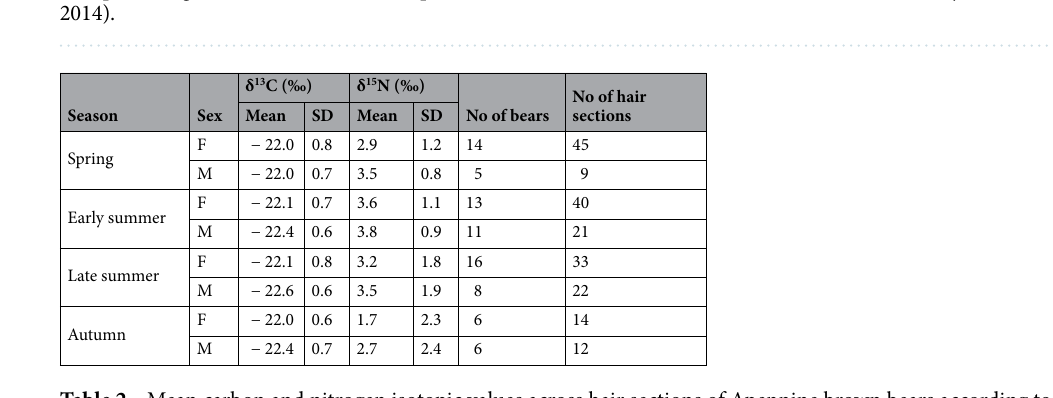
Table 2. Mean carbon and nitrogen isotopic values across hair sections of Apennine brown bears according to gender and dietary season (Abruzzo Lazio and Molise National Park, central Italy,